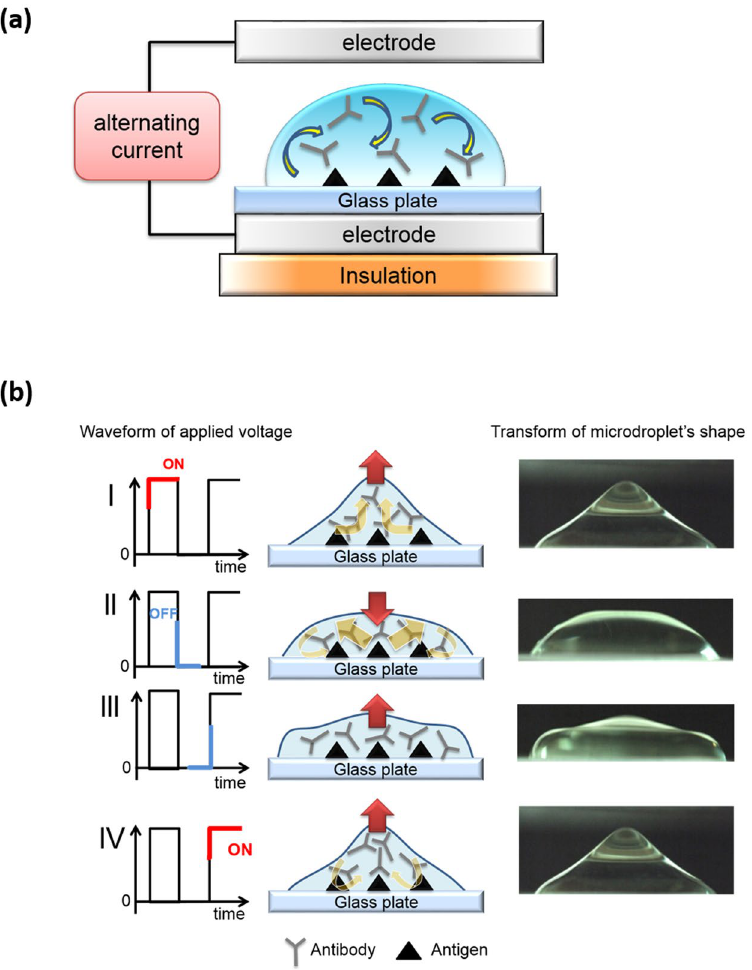
Figure 3. Schema of the device used to apply a high-voltage, low-frequency AC electric field. The slide was placed between the electrodes, and a high-voltage (4 KV), low-frequency (5 Hz) AC current was applied ( a ). The schema shows the changes within a microdroplet as the voltage is switched on and off in a time series (I → II → III → IV), which mixes the antibodies ( b